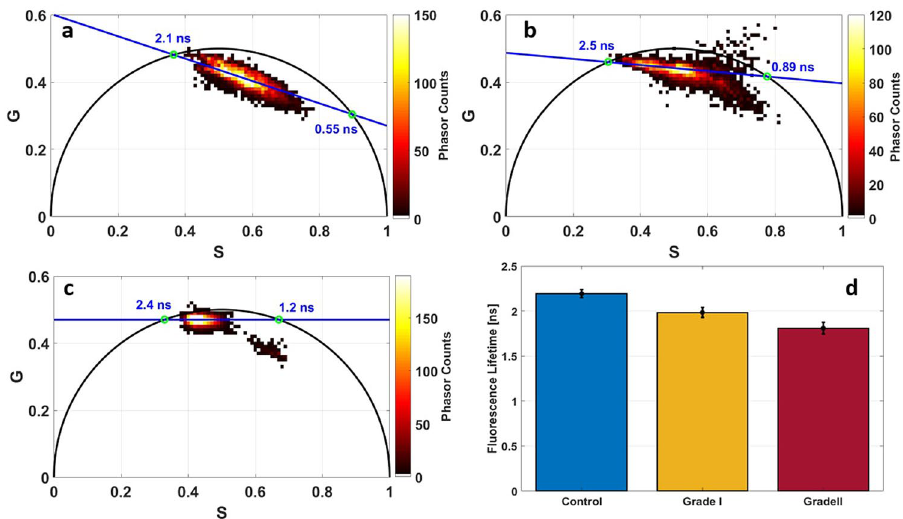
Figure 7. Fluorescence lifetime analysis of FAD ( a – c ) and NADH ( d ). Phasor FLIM histogram of FAD using 810 nm as excitation wavelength for control ( a ), grade I meningioma ( b ) and grade II meningioma ( c ), free and protein-bound FAD lifetime values are drawn as green circles intersecting with the universal circle; mean lifetime histogram of protein-bound NADH at 810 nm for control, grade I and grade II